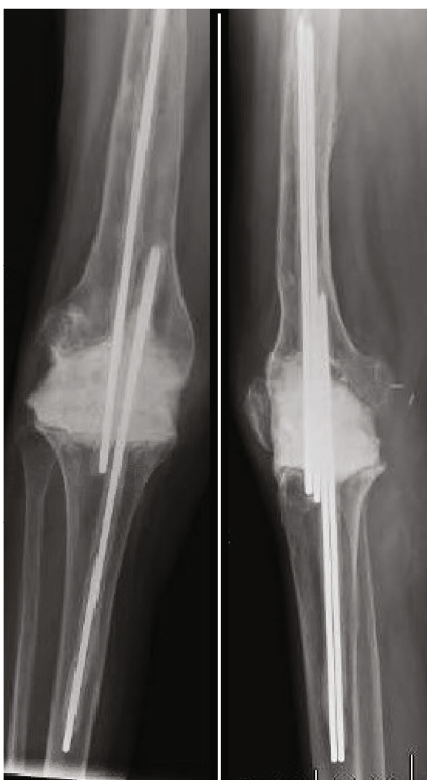
Figure 7: Right knee antibiotic spacer.